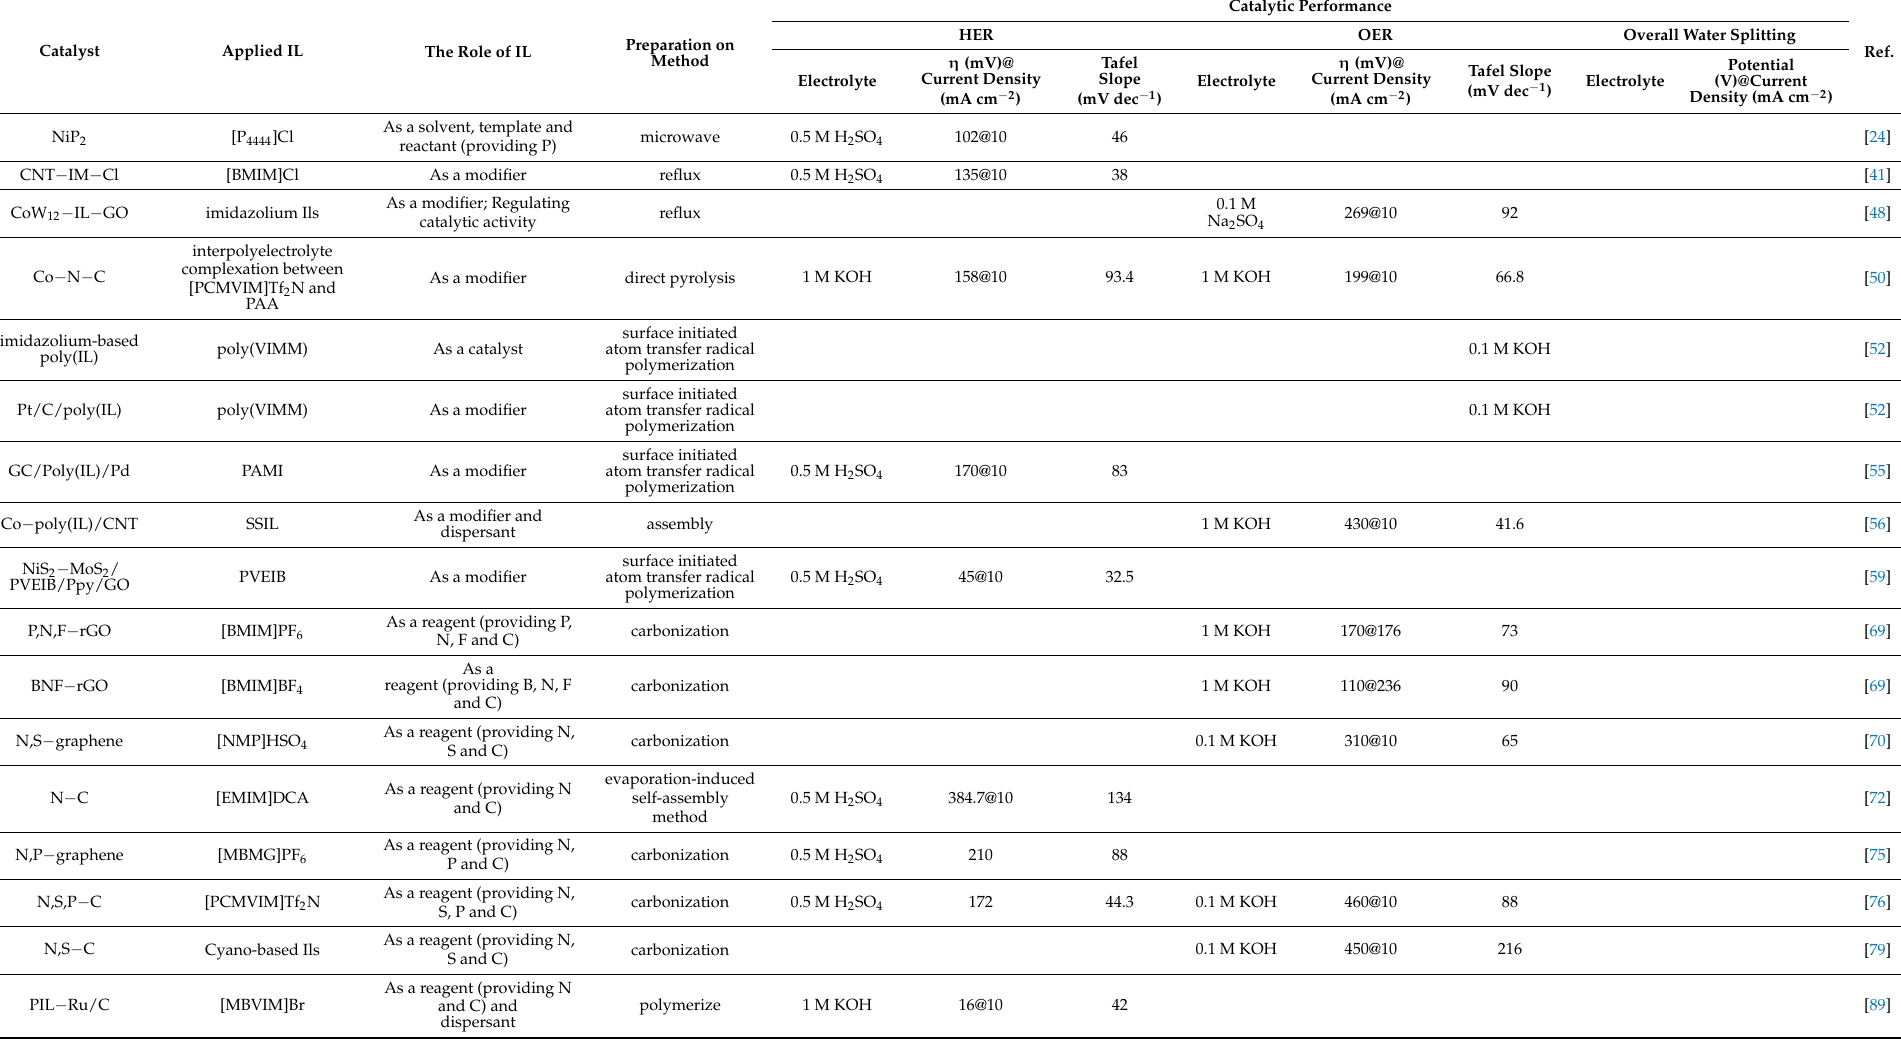
Table 1. Summary of HER, OER and overall water splitting performance of IL-derived catalysts involved in the Section